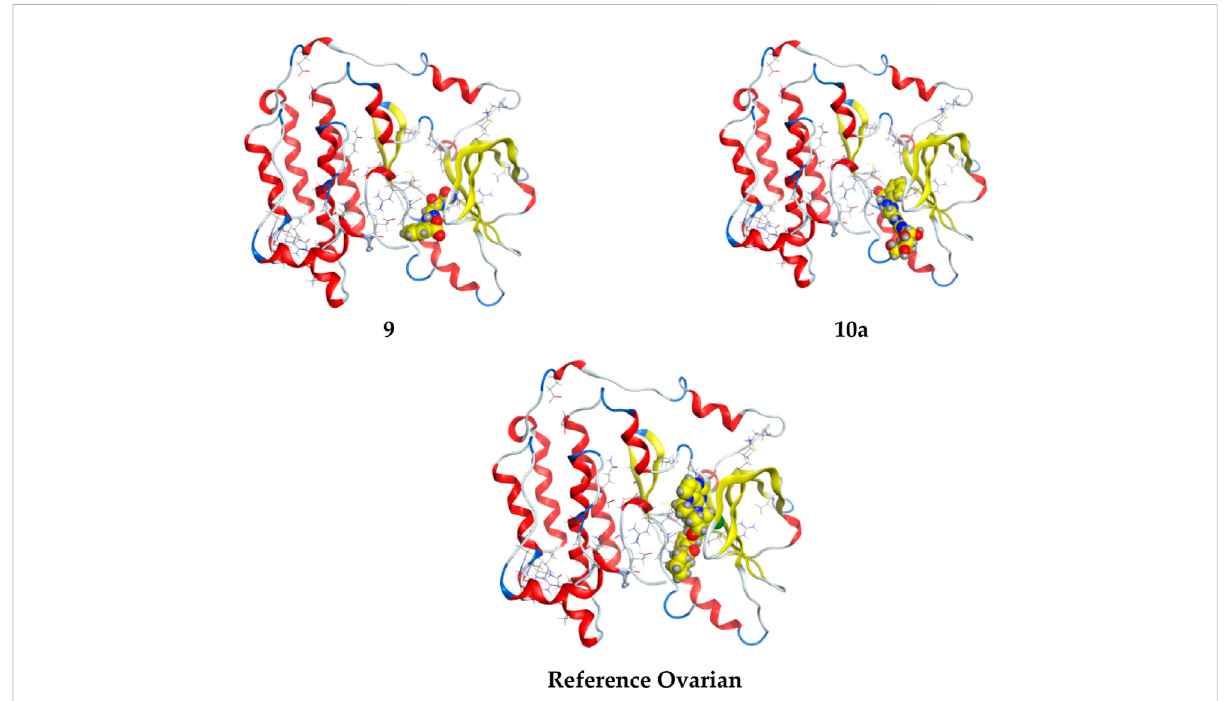
FIGURE 5 3D interaction of higher, lower, and reference compounds with the 3W2S ’ ovarian cancer protein ’